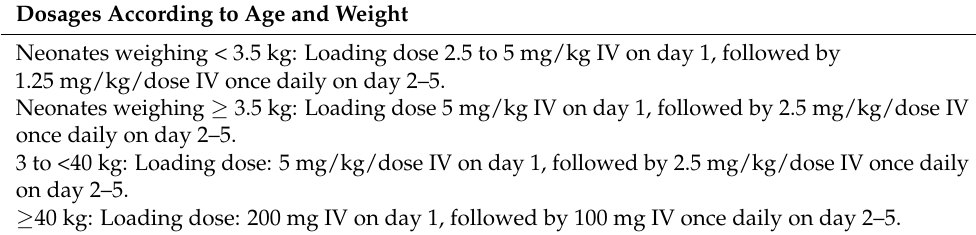
Table 1. Recommended dosage of remdesivir in neonates and children. Dosages According to Age and Weight